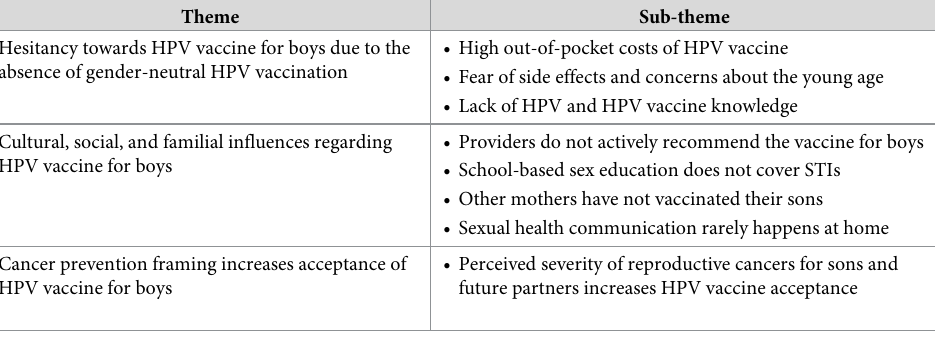
Table 2. Major themes and